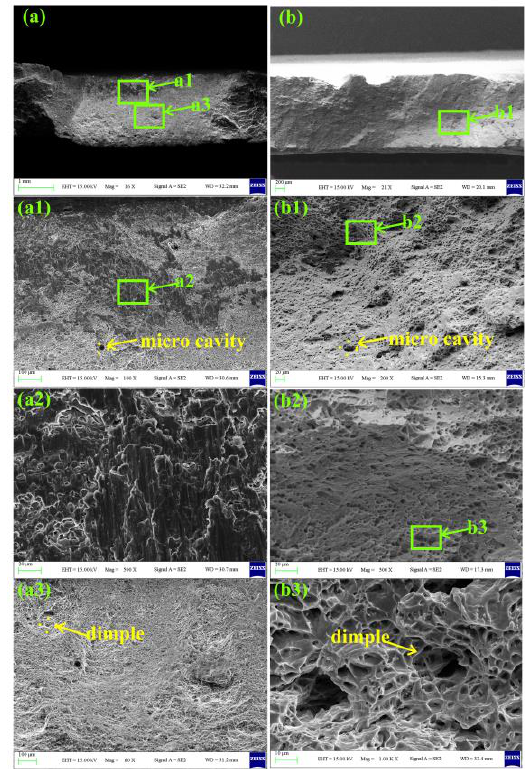
Figure 19. Tensile fracture at room temperature: ( a ) deposited by the NC process; ( b ) deposited by the OC process.